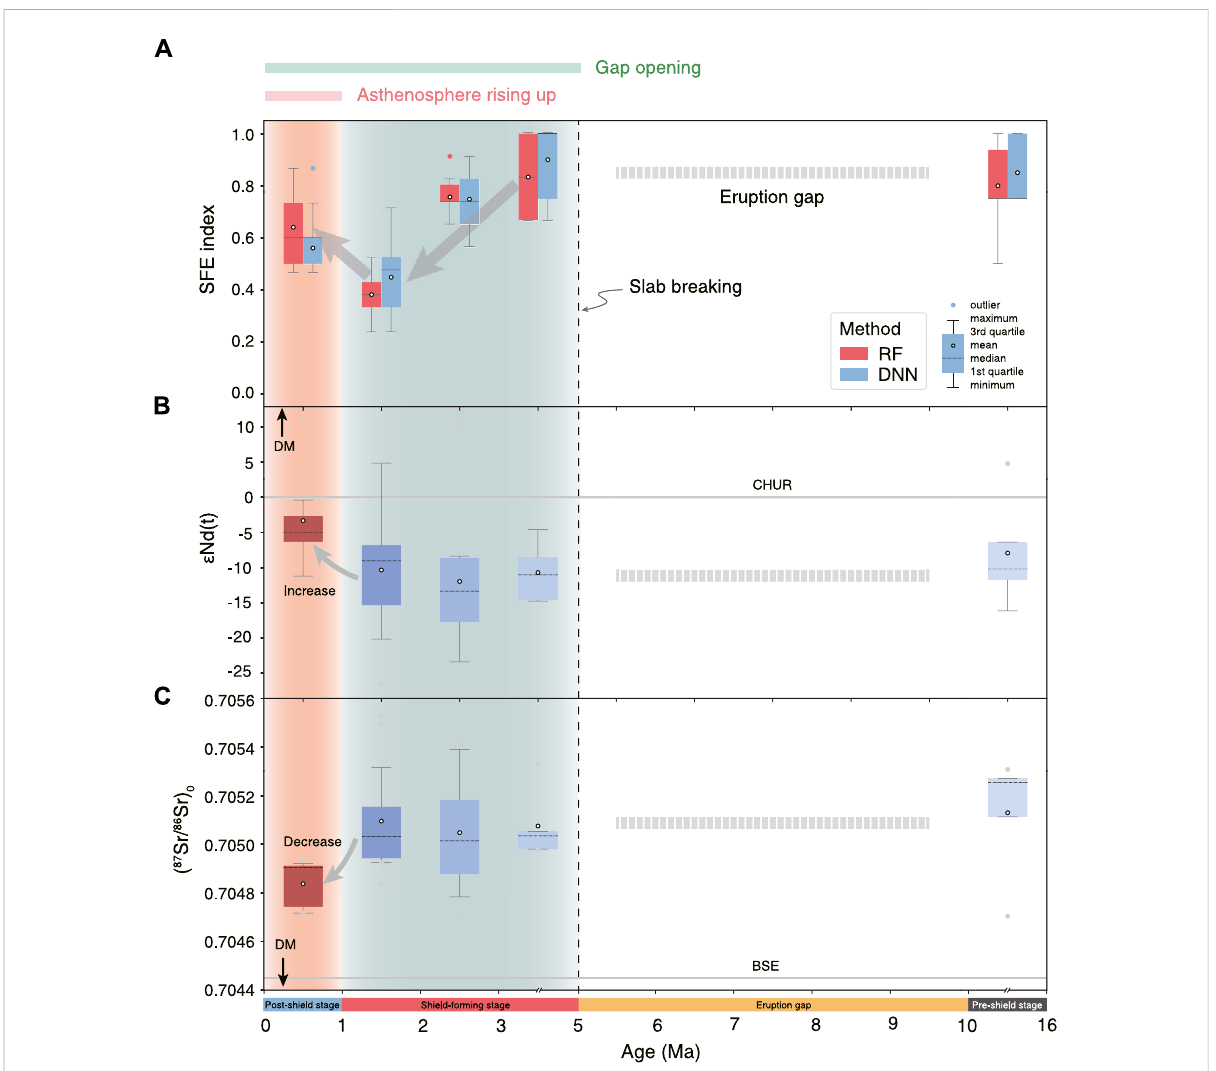
FIGURE 7 (A) ThepredictionsoftheRFandDNNmodelsforbasalts ’ SFEindexintheChangbaishan. (B,C) NdandSrisotopiccompositionalvariationswith timefortheChangbaishanbasaltsof16 – 0 Maages.Theincreaseof ε Nd(t) anddecreaseof( 87 Sr/ 86 Sr) 0 (initialratio)after1 Maindicateamoredepleted mantle component is added to the source of the Changbaishan basalts. SFE, subduction fl uid enrichment; CHUR, chondritic unfractionated reservoir; DM, depleted mantle; BSE, bulk silicate